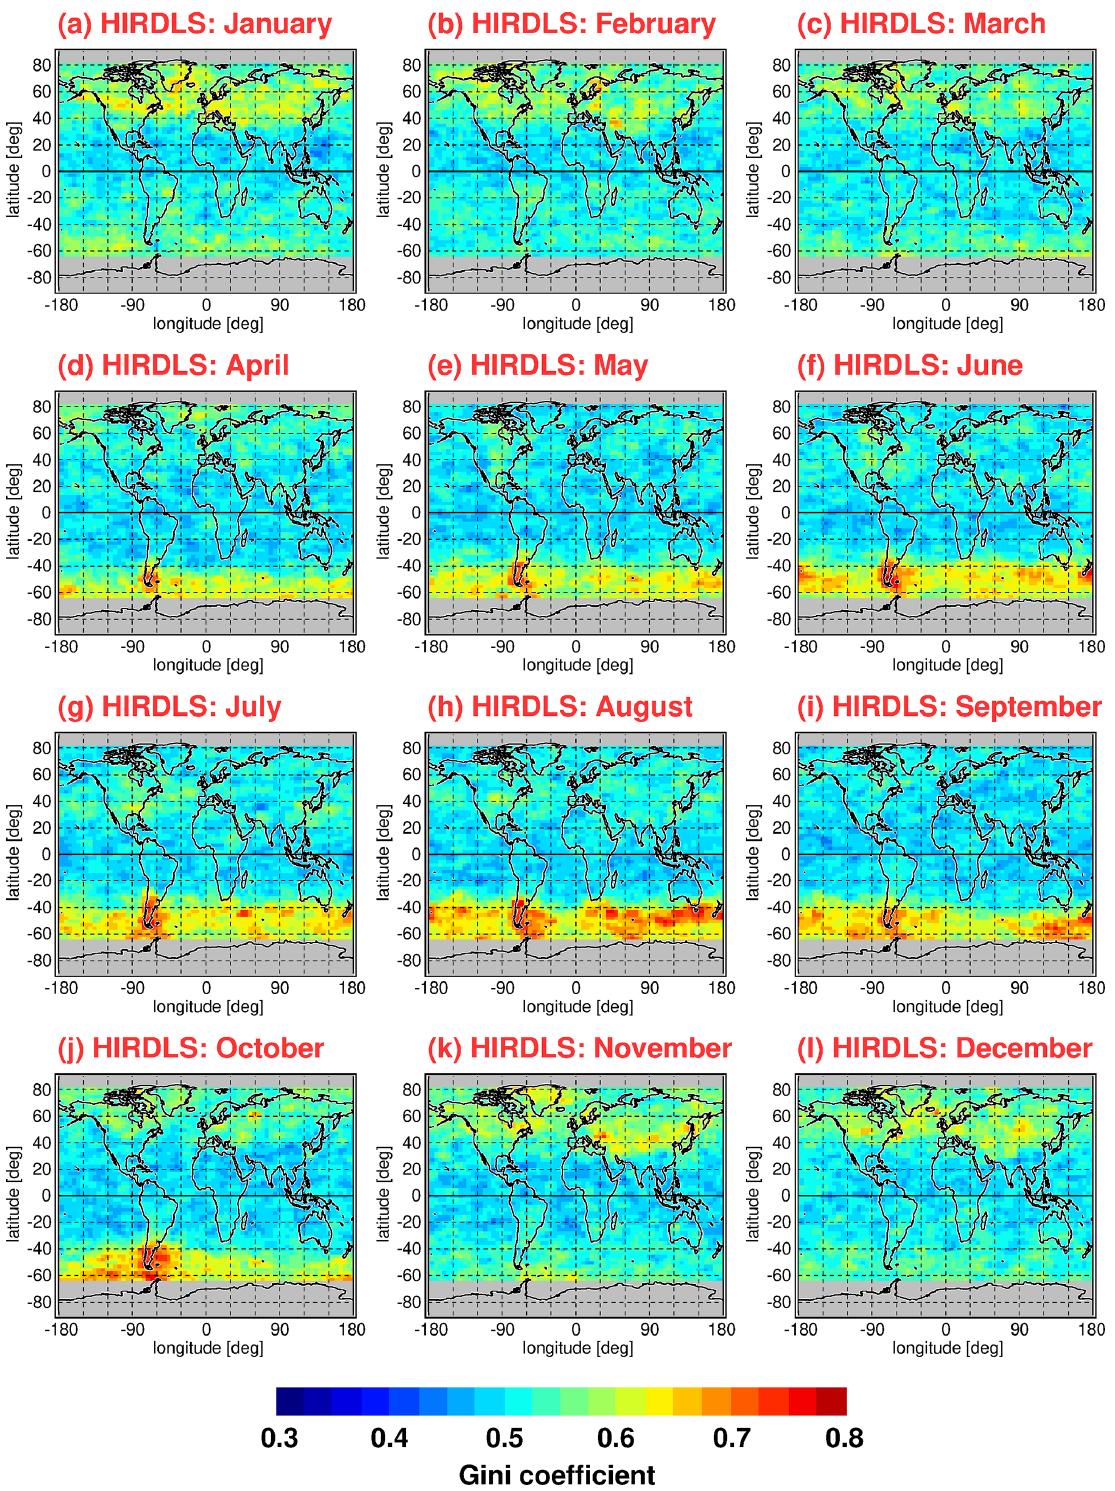
Figure 13. Same as Fig. 11 but for the Gini coefficients for HIRDLS gravity wave absolute momentum fluxes.